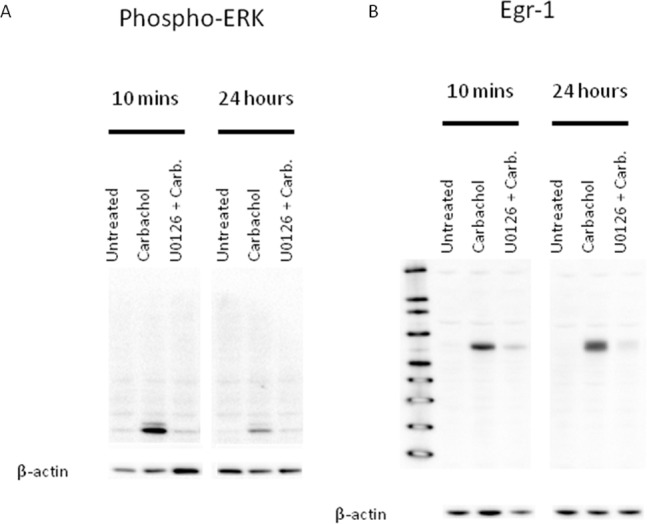
Western blots of pERK (A) and EGR-1 (B) at 10 min, 1 hr and 24 hours after Carbachol +/− U0126.A, pERK Western showing ERK phosphorylation at 10-min and 24 hours after addition of carbachol to HEK293-M1 cells. The MEK blocker U0126 completely inhibited this ERK phosphorylation. B, EGR-1 induction at 1 hour and 24 hours after addition of carbachol to HEK293-M1 cells. The MEK blocker U0126 completely inhibited this EGR-1 induction.